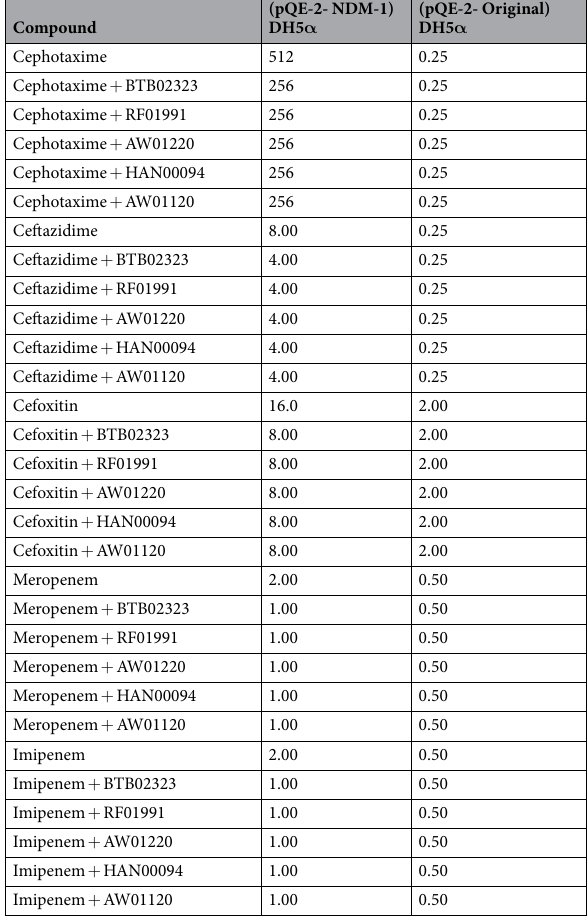
Table 4. Minimum inhibitory concentration values ( µ g/ml) of antibiotics and antibiotic-inhibitor combinations for E. coli DH5 α transformed with recombinant NDM-1 and original DH5 α (with null